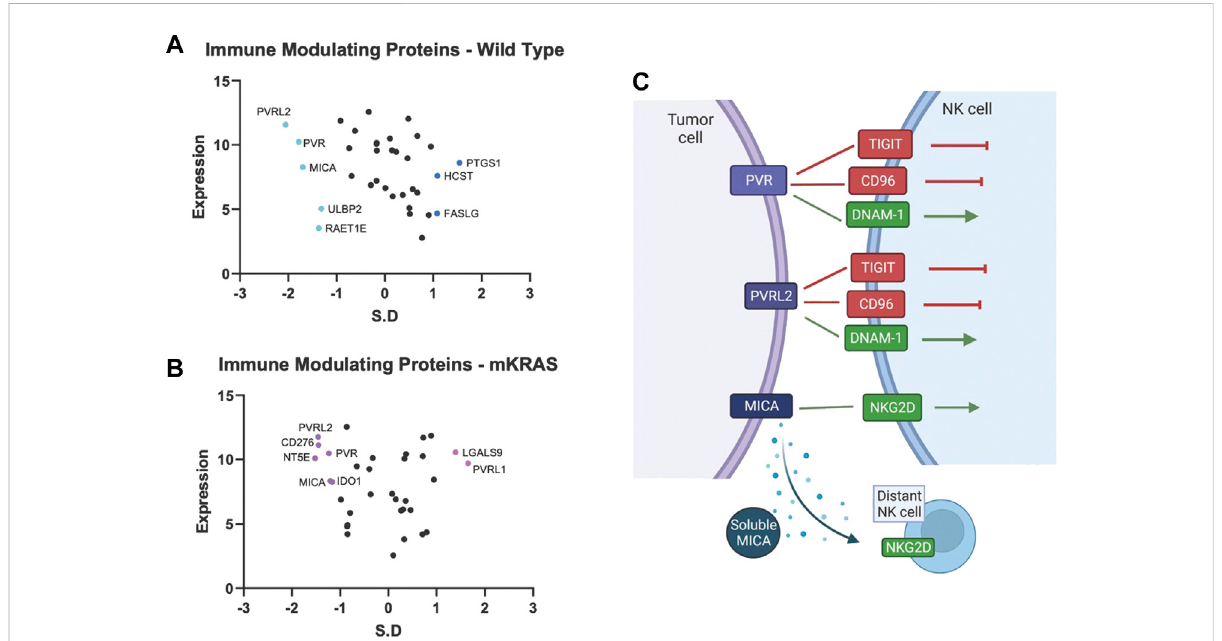
FIGURE 4 Geneconservation ingenesencodingimmune modulatingproteinshighlights theimportantrole ofNK cellsinlungcancer. Geneconservation score, measured as the standard residual from the regression line (SR) graphed against genes expression levels (Log2) for WT (A) and mKRAS (B) . Conserved genes (SR ≤ -1.0) and over-mutated genes (SR ≥ 1.0) are colored and labelled with text. PVR, PVRL2, and MICA can activate or inhibit NK cells depending on NK receptor expression and solubility of MICA (C) . Standardized residual (SR). Created with